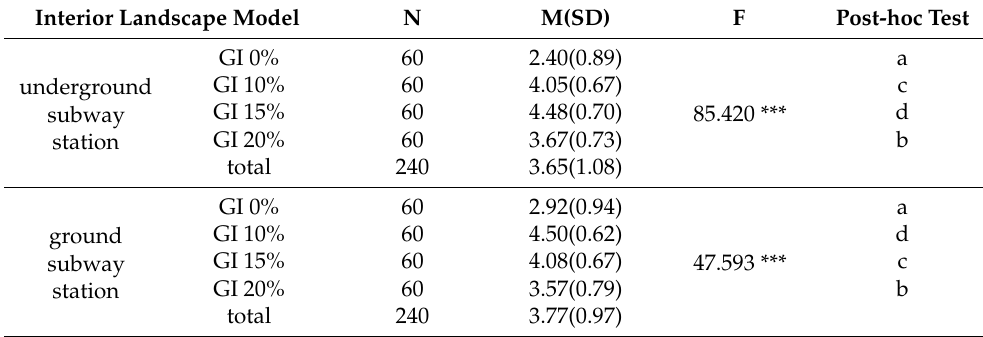
Table 5. Analysis of Preferences of Interior Landscape Models in Subway according to